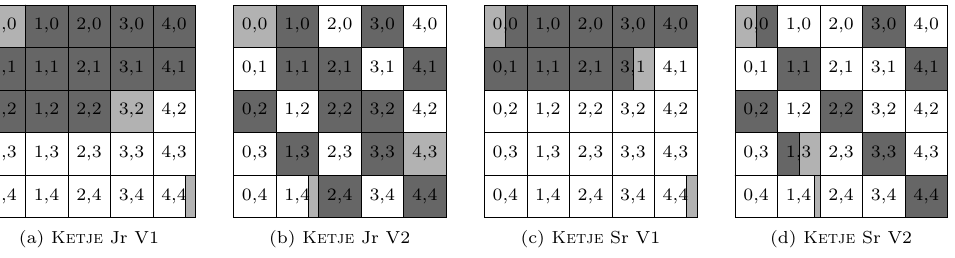
Figure 4: Key pack of Ketje Jr and Ketje Sr, where gray lanes are the key, light gray lanes denote padded or encoded bits and white lanes are the